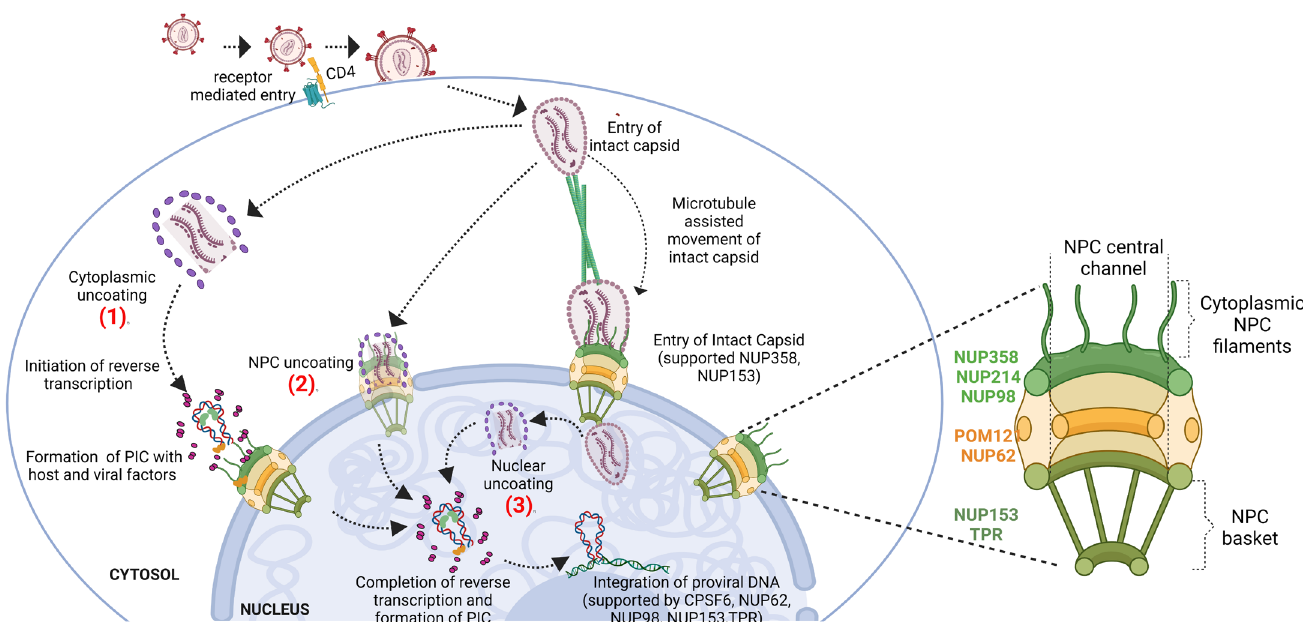
Figure 1. Schematic representation of the models depicting the import of HIV-1 in a host cell. HIV-1 enters the host cell by fusion with the host membrane releasing its intact capsid into the cytoplasm. With the help of the microtubular network, the intact capsid is transported to the cytoplasmic periphery of the nucleus. The uncoating of the capsid occurs either in the cytoplasm (1) or at the NPC (2) or in the nucleus (3). As detailed in the text, the interaction of capsid with NUP153, NUP358, and other host proteins favors nuclear import. The disassembly of the capsid, reverse transcription, and PIC formation occur in the nucleus. The proviral DNA is integrated into the host genome supported by CPSF6, NUP62, NUP98, and NUP153. (1), (2) and (3) refer to the Schemes 1, 2 and 3 described in the text. Inset: The nucleoporins of NPC associated with the import of capsid and integration of the HIV-1 genome are listed.